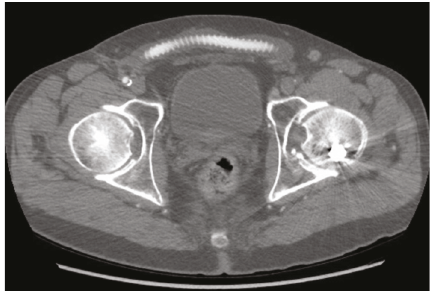
Figure 2: Fluid surrounding the femorofemoral bypass graft.